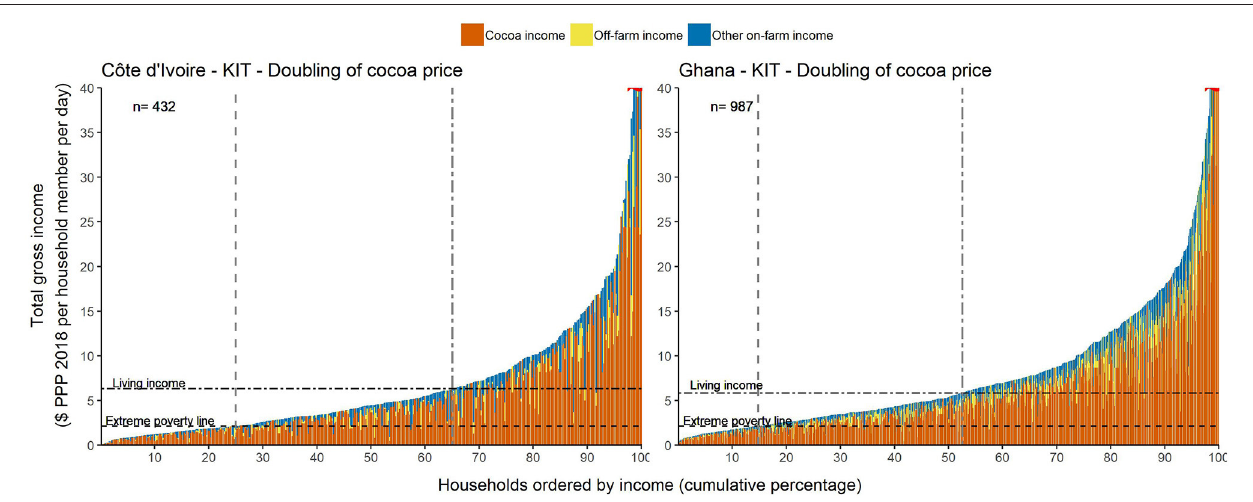
FIGURE 4 | Gross income per household member per day ($ PPP 2018) for each household of the KIT datasets when cocoa prices would double compared with the prices of 2015/2016, compared with the World Bank extreme poverty line and the Living Income benchmark based on Smith and Sarpong (2018) for Ghana and CIRES (2018) for Côte